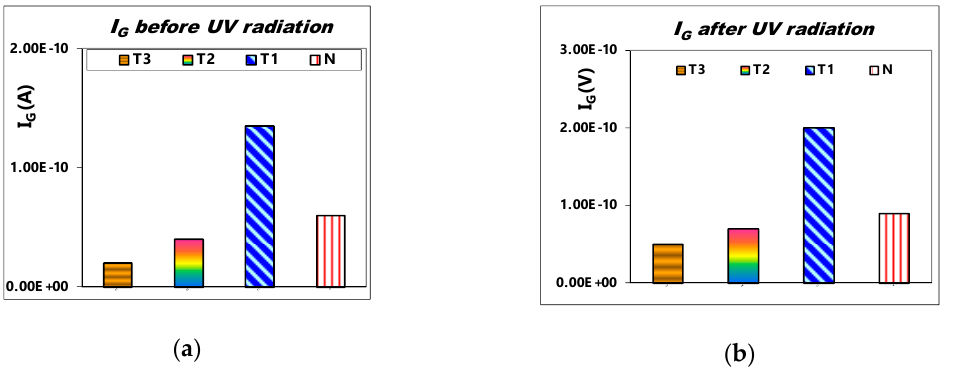
Figure 7. The gate leakage current at PGV 30V for an SAHAOS-T3 capacitor device ( a ) before UV irradiation; ( b ) after U100G30 irradiation.